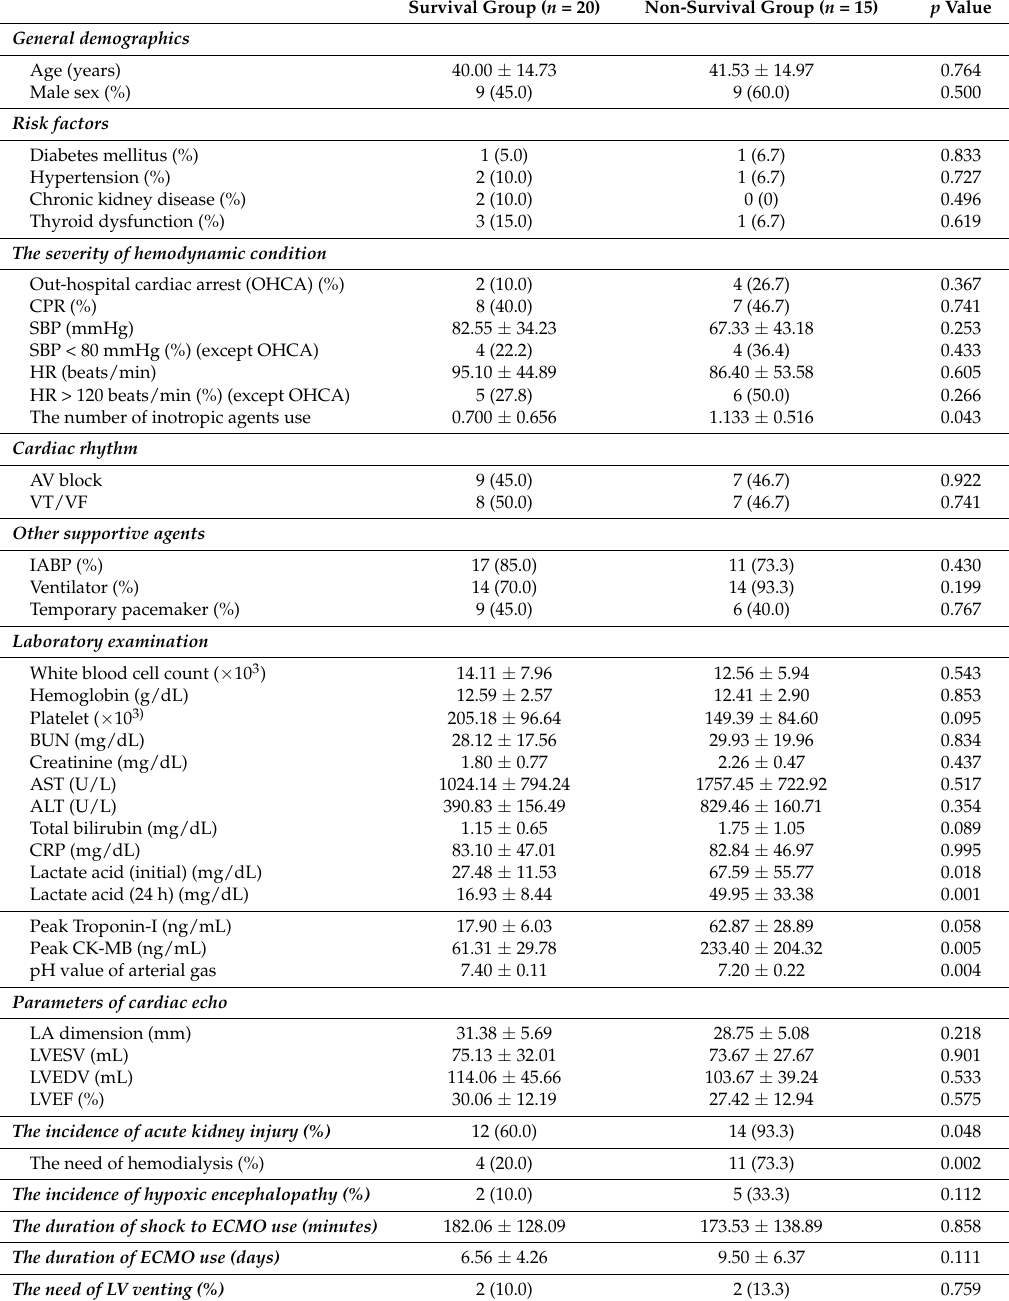
Table 1. Baseline characteristics of study